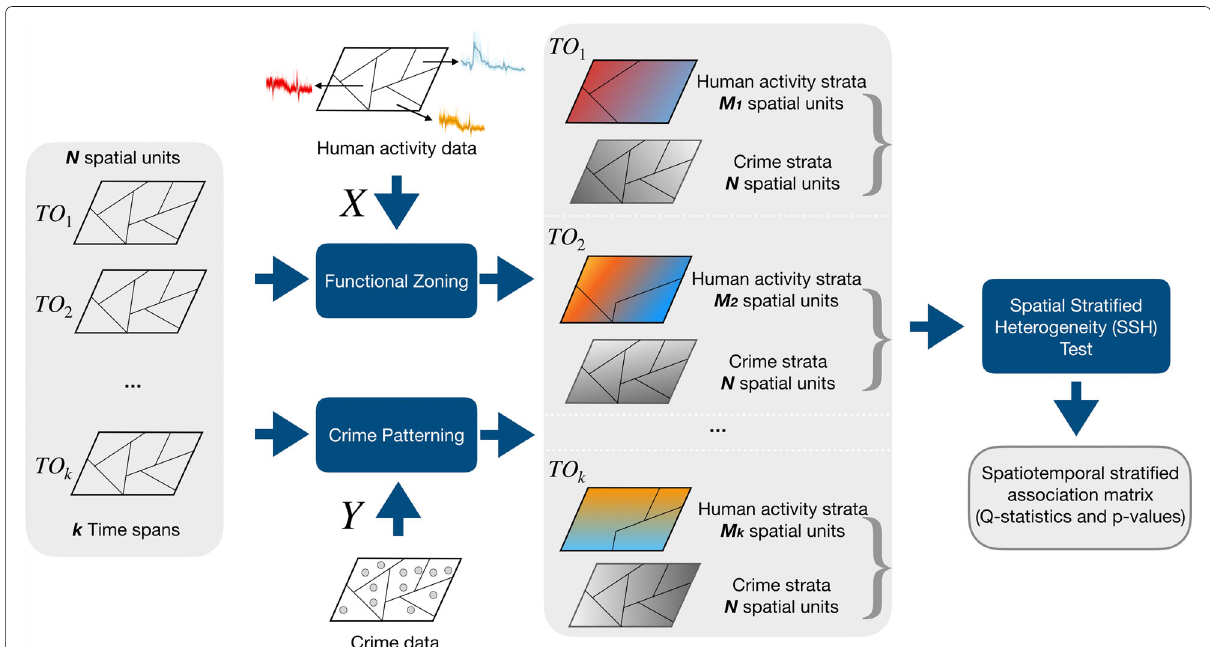
Fig. 1 Analytical framework for detecting the spatio-temporal stratified association between human activities and crime